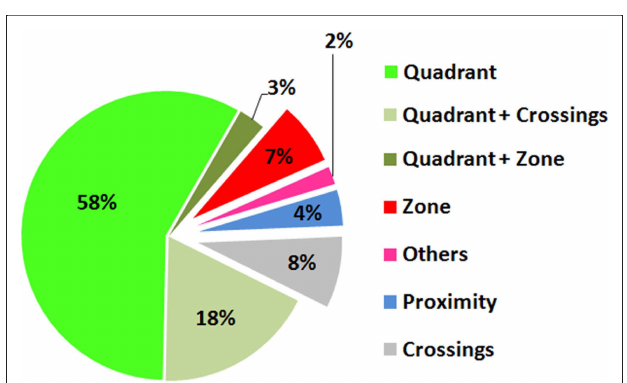
Corresponding quantifi cation of probe test performance is shown below for the four widely used probe test measures: quadrant (Q), zone (Z crossings (X) and proximity (P).